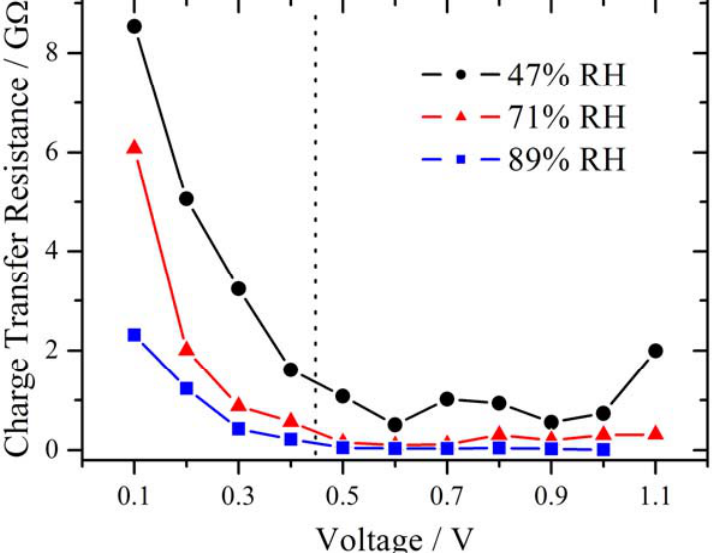
Figure 8. Simulated charge transfer resistance as a function of the voltage at different relative humidities, showing a pronounced decline with increasing voltage. The charge transfer resistance is smaller at higher relative humidity. In the section to the left of the dotted line the RC-circuit and to the right the modified Randles-circuit is